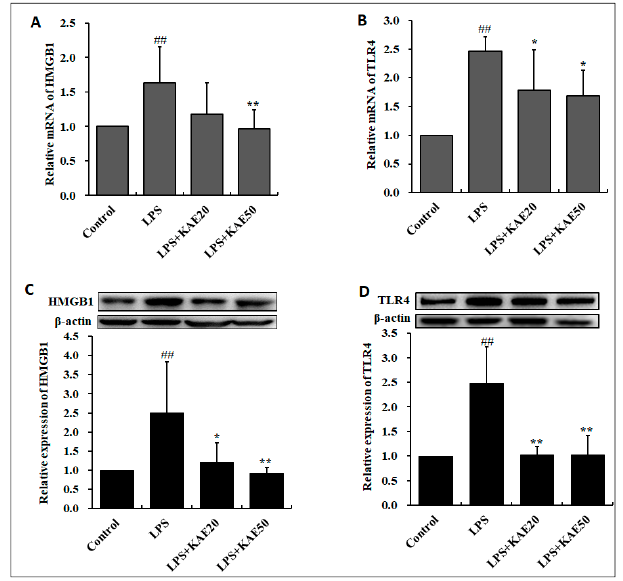
Figure 5. Effect of kaempferol on mRNA and protein expression of HMGB1 and TLR4 in the striatum of mice injured by LPS. ( A ) mRNA expression of HMGB1; ( B ) mRNA expression of TLR4; ( C ) protein expression of HMGB1; and, ( D ) protein expression of TLR4. Values are mean ± SD ( n = 4). ## p < 0.01 vs. Control group; * p < 0.05, ** p < 0.01 vs. LPS